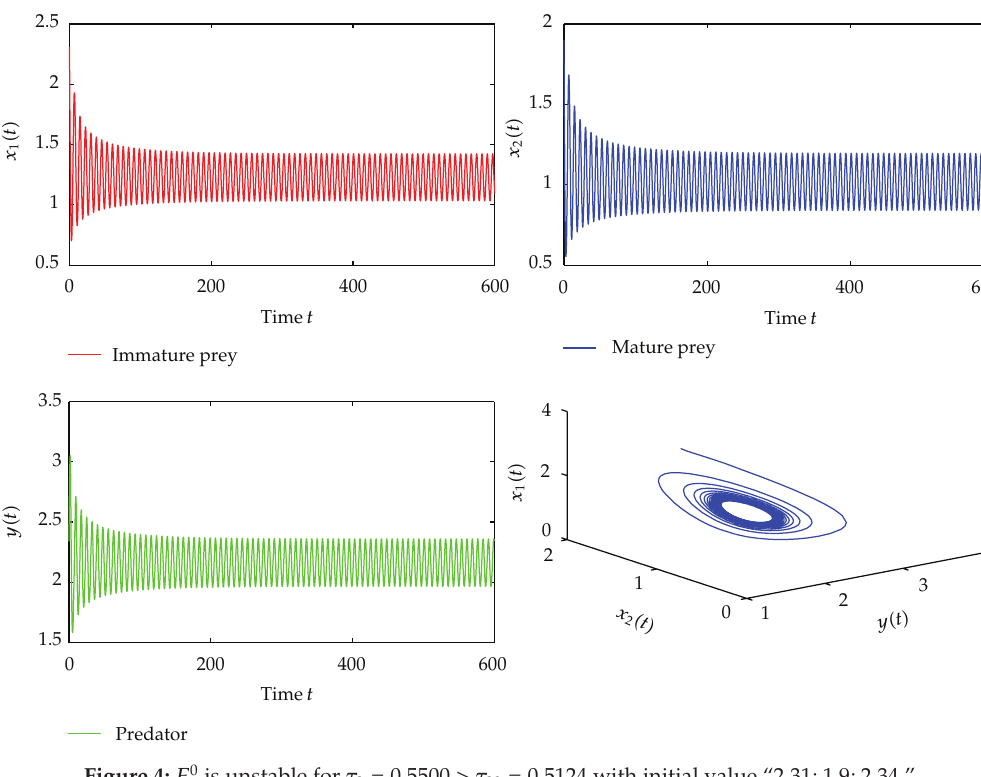
Figure 4: E 0 is unstable for τ 2 (cid:6) 0 . 5500 > τ 20 (cid:6) 0 . 5124 with initial value “2.31; 1.9;